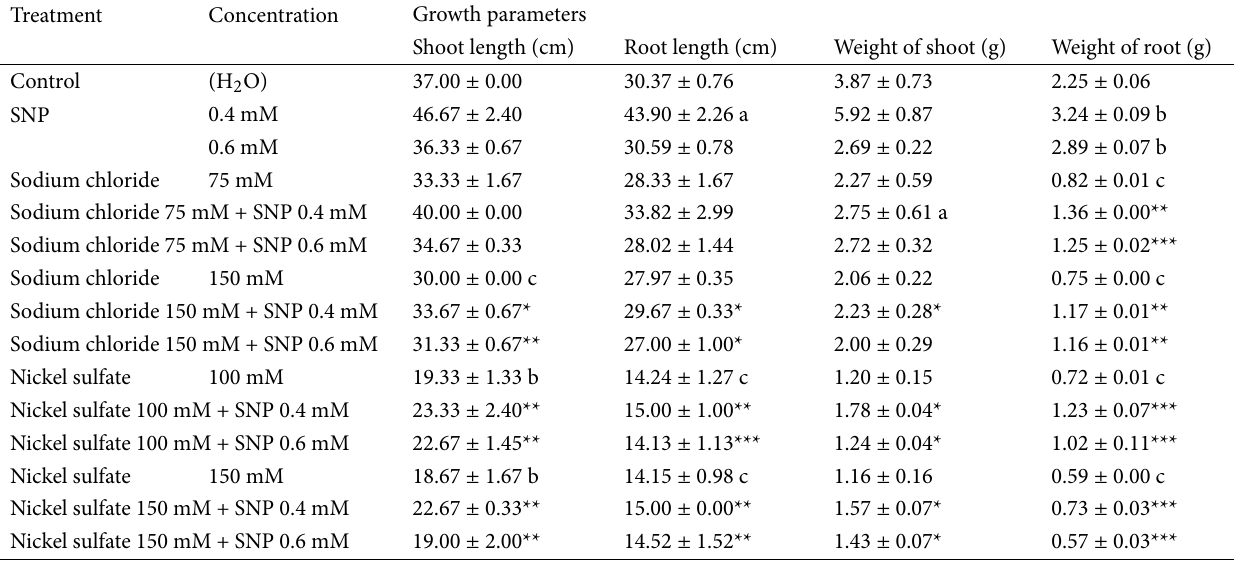
Table 1 Effect of sodium nitroprusside (SNP) on growth characteristics of Lupinus albus subsp. termis (Forssk.) Ponert, under sodium chloride (0, 75, and 150 mM) and nickel sulfate (0, 100, and 150 mM) stress. Data are mean ± SE (standard error) of five replicates. Treatment Concentration Growth